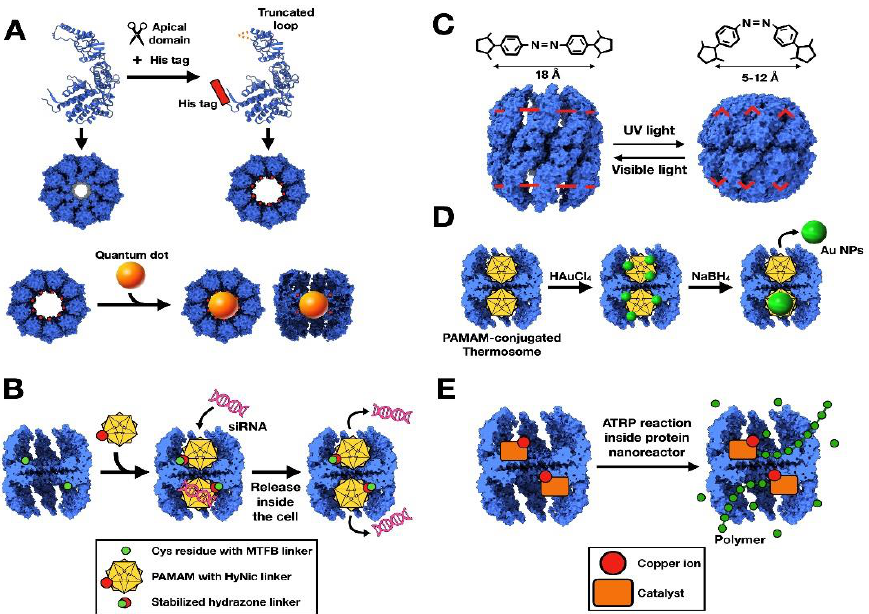
Figure 3. Nanotechnological applications for Type II chaperonins. ( A ) Strategy for the preparation of a complex between a modified chaperonin and a quantum dot [22]. The cavity entrance is widened by removal of the helical protrusion, and a His tag is placed in its interior, at one of chaperonin sequence ends. ( B ) Strategy followed by Nussbaumer et al. [20] to modify a Type II chaperonin (the β -only Thermoplasma acidophilum thermosome) so that it could be used as a siRNA carrier. ( C ) Structural changes induced in the thermosome from Methanococcus maripaludis by isomerization of the azobenzene dimaleimide (top), which reacts with two Cys residues in opposite positions of the equatorial domains of two adjacent subunits, which in response to light leads to closure or aperture of the cavity (bottom); modified from [23]. ( D ) Section of the thermosome structure from Thermoplasma acidophilum in the open conformation, in which PAMAM has been conjugated to Cys residues introduced in the chaperonin cavity. The scheme shows how AuNPs are formed using dendritic polymers as nucleation sites [24]. ( E ) The chaperonin cavity (shown in section) can be used as a nanoreactor for atom-transfer radical polymerization, as described in [25]. Another example of Type II chaperonins modified for biotechnological purposes is the which alternate in an octameric ring. In this case, the ring can also be formed by β subunit the sequence and a specific one is inserted within the thermosome cavity [20] (Figure 3B). These residues were made to react with the heterobifunctional linker maleimido trioxa-6- formylbenzamide (MTFB). Additionally, the polycationic dendrimer poly(amidoamine) (PAMAM) could be linked to the modified chaperonin, with the dendrimers enclosed in the cavity used to complex siRNA through electrostatic interactions. The siRNA is protected within the chaperonin cavity from RNase attack, and could be delivered to U87 cells inducing gene silencing. The process was made even more efficient by adding the cell-penetrating peptide TAT (QPPRRRQRRKKRG) to the modified chaperonin, which aided in cell uptake and subsequent siRNA delivery